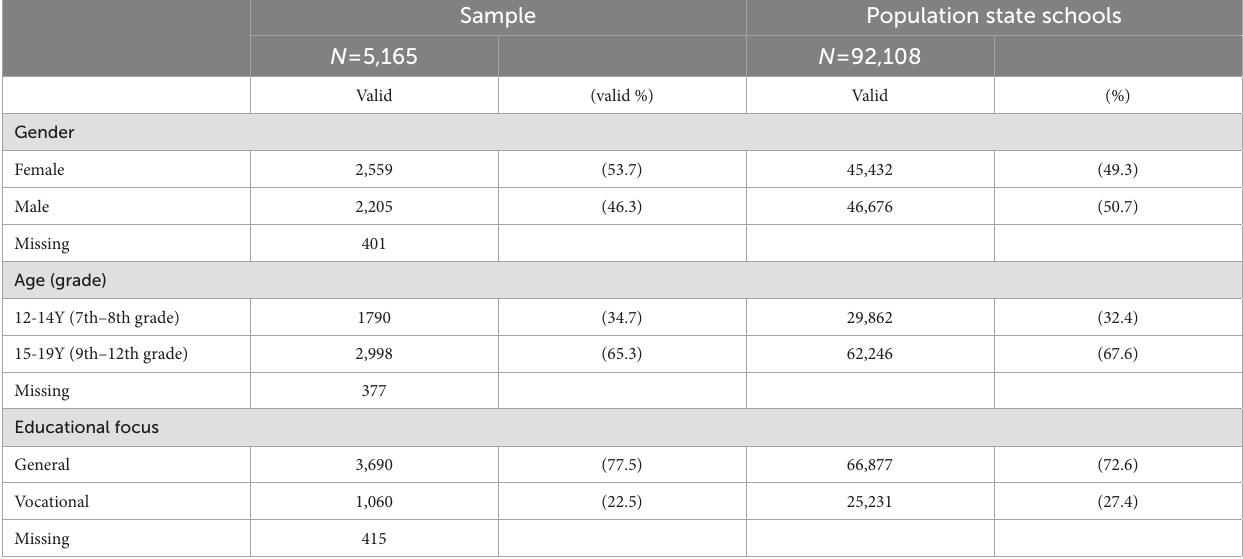
TABLE 1 Characteristics of the